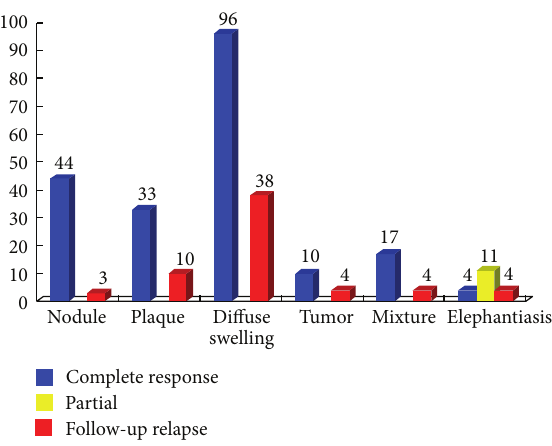
Figure 13: Clinical outcome of 215 cases with PTM after therapy and in the 1.5-year follow-up. After diagnosed at our department, 215 cases received therapy and underwent 1.5-year follow-up after therapy. The numbers above the color rectangles represented the casenumbersof6variants,respectively.In6variants,bluerectangles indicated the case numbers of complete response to therapy; yellow rectangles showed the case numbers of partial response to therapy and red rectangles indicated the case numbers of relapse after therapy in the 1.5-year